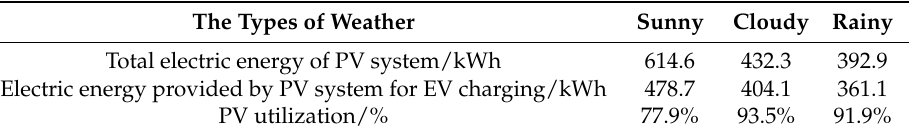
Table 2. PV utilization for EV charging in three weather